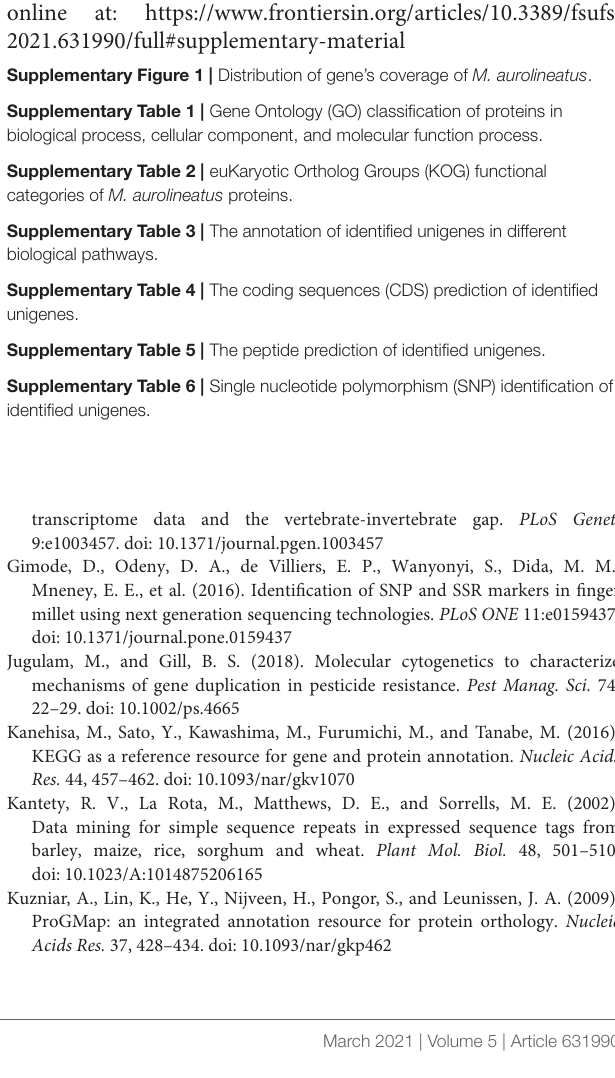
Supplementary Figure 1 | Distribution of gene’s coverage of M. aurolineatus .